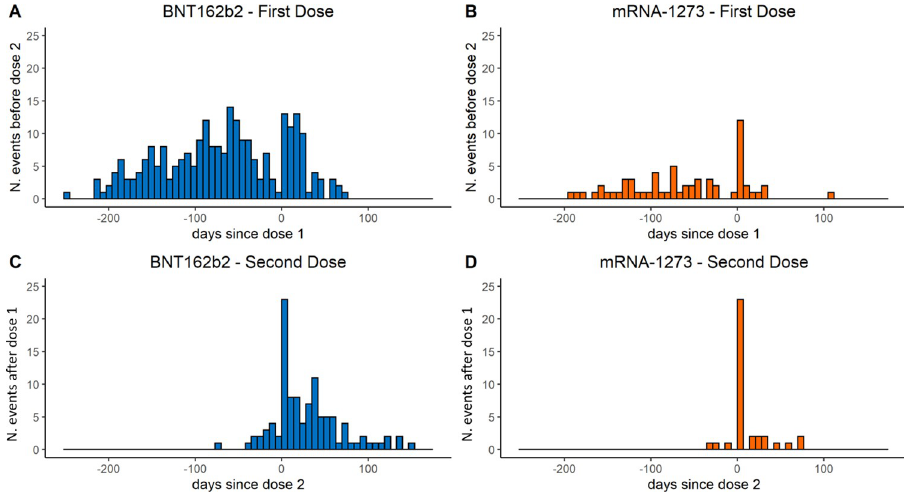
Fig 1. Days from mRNA vaccination to myocarditis/pericarditis in population aged 12–39 years by vaccine product and dose. Top (panel A-BNT162b and B-mRNA-1273): days from dose 1, for events occurring before dose 2 if present, or at any time if dose 2 not present. Bottom (panel C-BNT162b and D-mRNA-1273): days from dose 2, for events occurring after dose 1. � Each bar corresponds to 1 week starting from day 0.